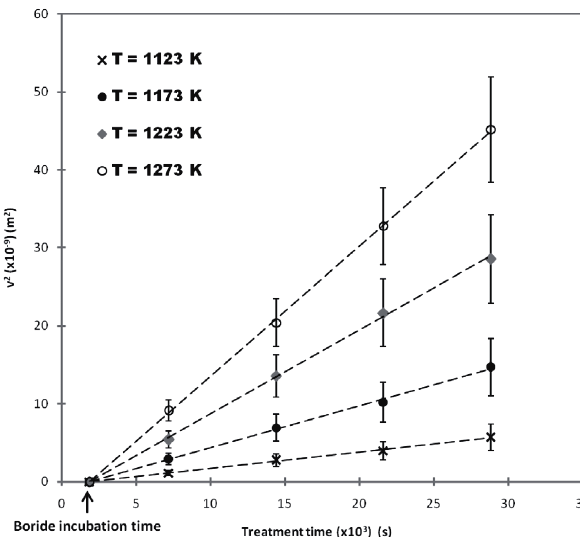
Fig. 9: The square of Fe 2 B layer thickness as a function of the boriding time.